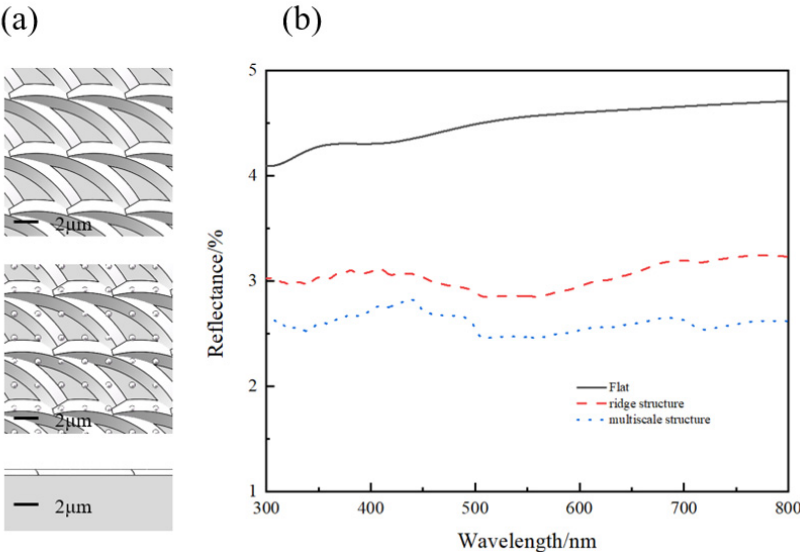
Figure 3. Simulation diagram of the anti-reflection effect of a multiscale structure. ( a ) simulation model, ( b ) reflectance